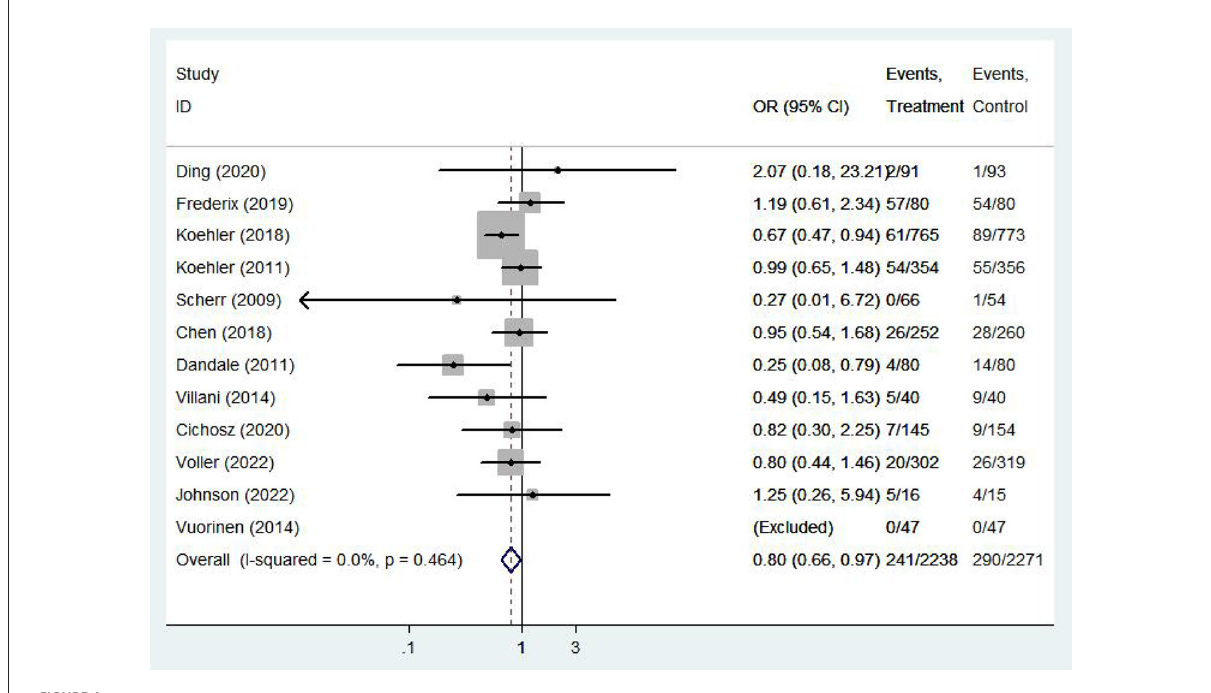
FIGURE4 Forest plots showing the effects of all-cause mortality.